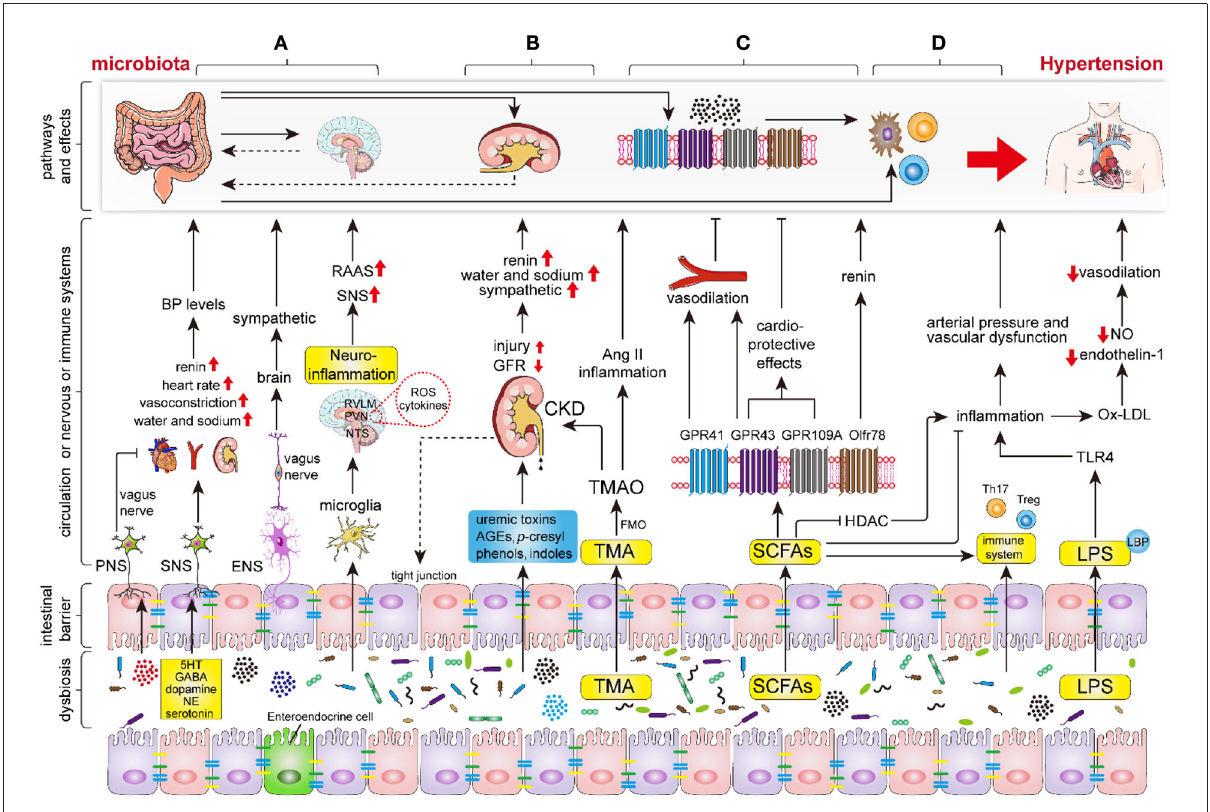
FIGURE2 The key mechanisms of intestinal microbiota in regulating the hypertension process. Intestinal dysbiosis leads to disruption of the nervous system, renal function, intestinal SCFAs, immune system, and increases LPS production and intestinal permeability, thereby aggravating the progression of hypertension. (A) Intestinal microbiota and its metabolites (mainly including GABA, dopamine, noradrenaline and 5HT) regulate hypertension by modifying sympathetic and vagal nerve activity and neuroinflammatory response through the gut-brain axis. (B) Intestinal microbiota and its metabolites regulate hypertension via renal sympathetic regulation, humoral regulation, vasoactive substances (RAAS, nitric oxide, and endothelin), and even lead to hypertension by triggering chronic kidney disease (CKD). (C) The indigestible dietary fiber was fermented into SCFAs, primarily involving acetate, propionate, and butyrate, by intestinal microbiota. Subsequently, the SCFAs regulate hypertension via binding to the specific GPCRs which mainly include GPR43, GPR41, GPR109A, and Olfr78. (D) Intestinal microbiota and endotoxins (LPS) regulate hypertension via the immune and inflammation systems. Abbreviations: BP, blood pressure; PNS, peripheral nervous system; SNS, sympathetic nervous system; ENS, enteric nervous system; RAAS, renin-angiotensin-aldosterone system; GABA, gamma-aminobutyric acid; NE, noradrenaline; 5HT, 5-hydroxytryptamine; ROS, reactive oxygen species; TMA, trimethylamine; TMAO, trimethylamine-N-oxide; FMO, flavin monooxygenases; CKD, chronic kidney disease; SCFAs, short-chain fatty acids; GPR, G protein